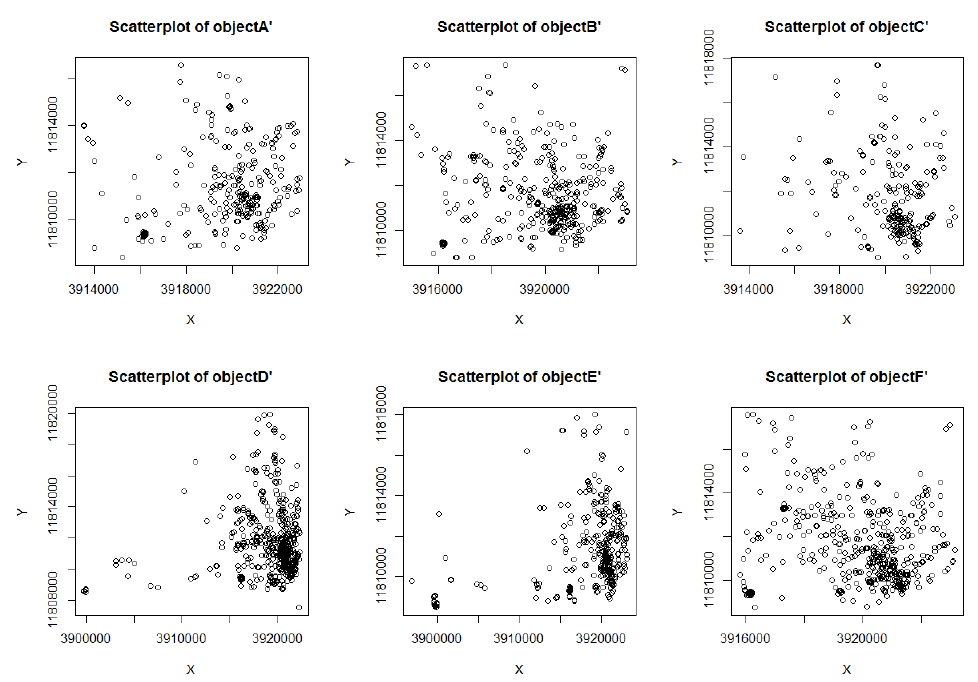
Figure 7. The scatter plot of object position profiles in CFRLS. Table 1. Object profile data.